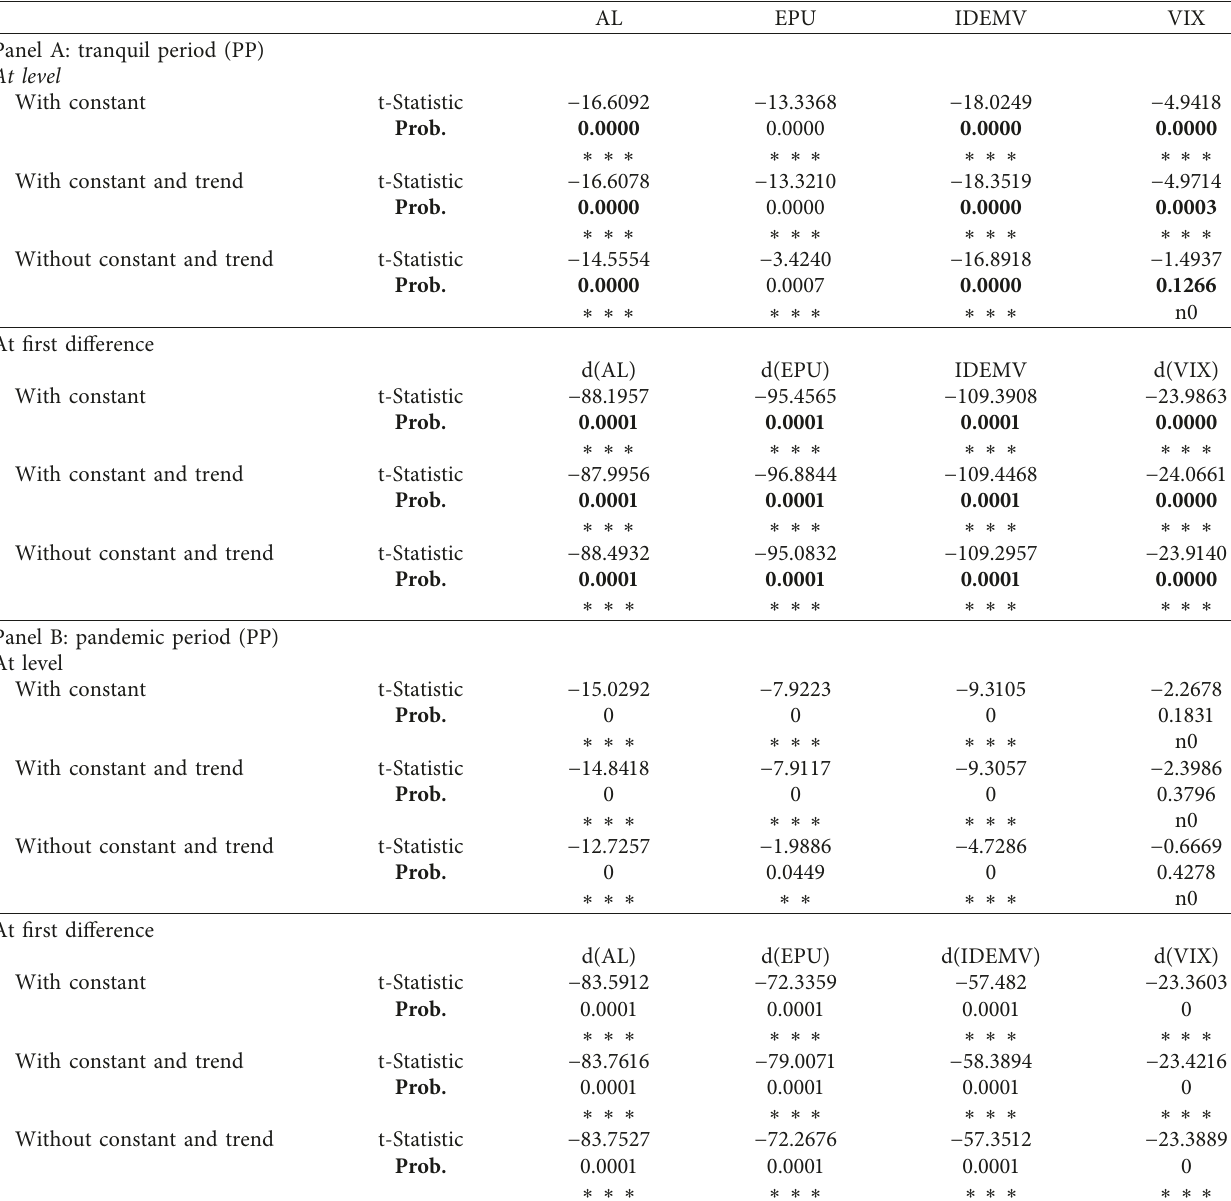
Table 3: Unit root